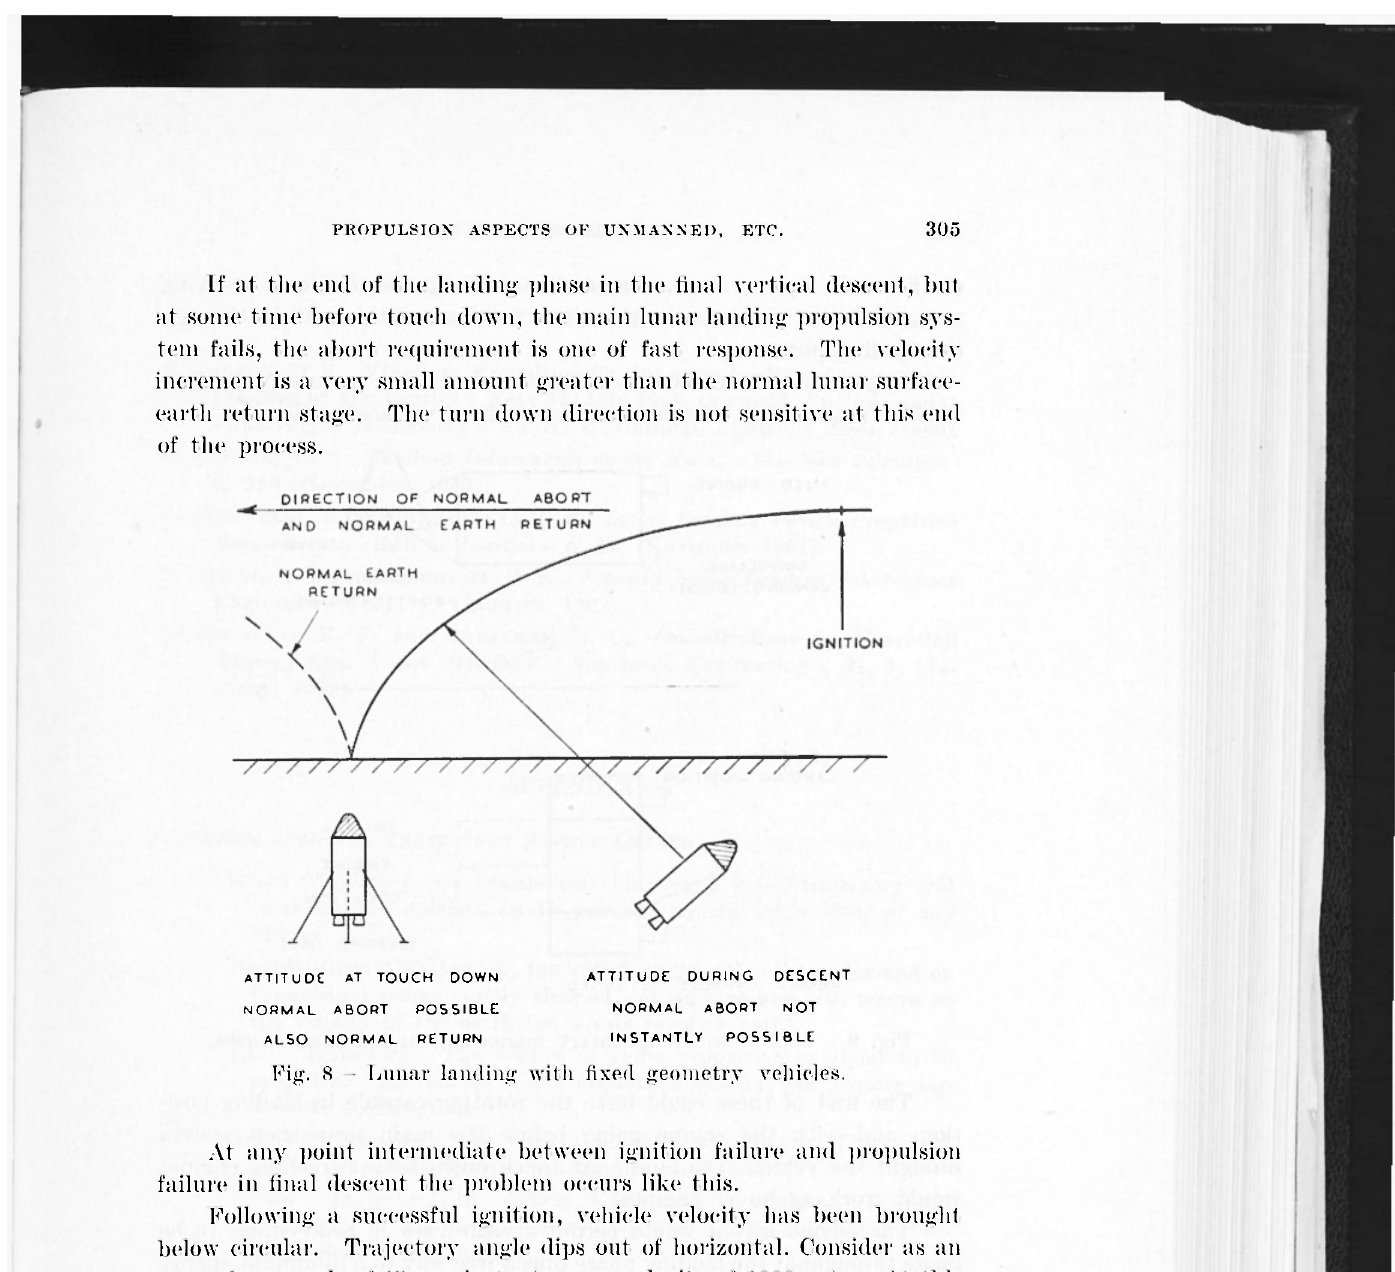
Fig. 8 - Lunar landing with fixed geometry